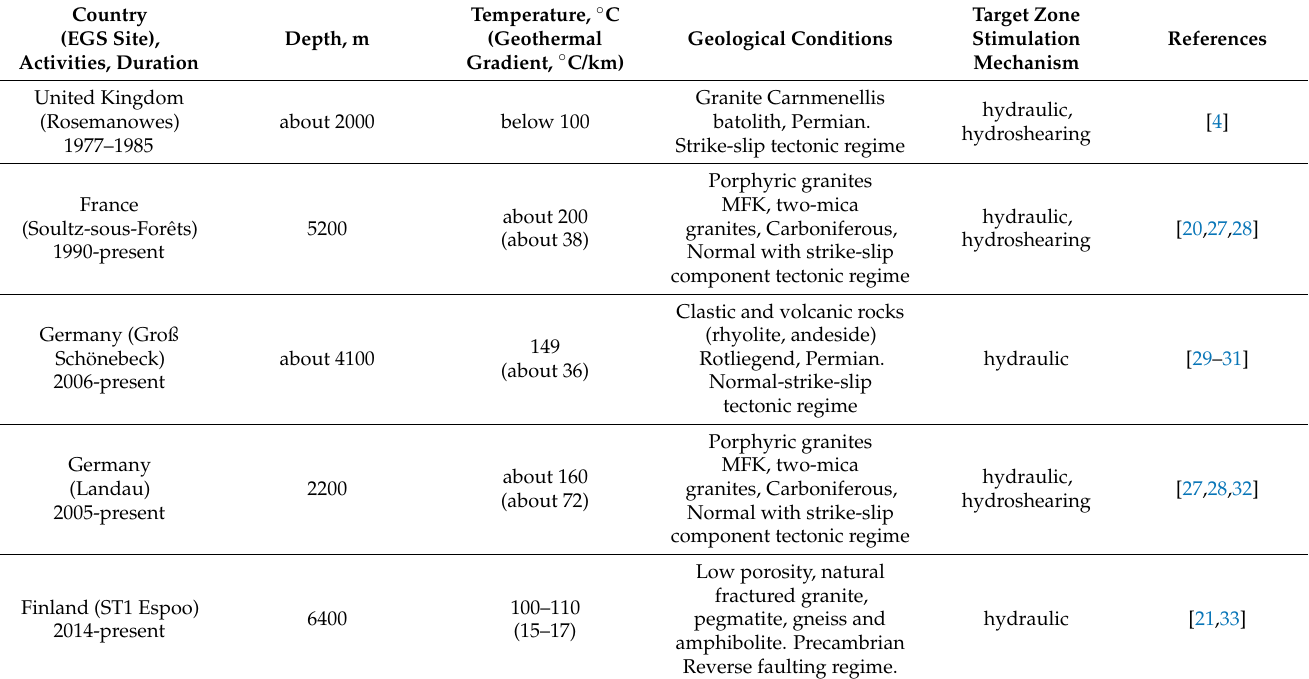
Table 1. Selected geological and technological data on European EGS